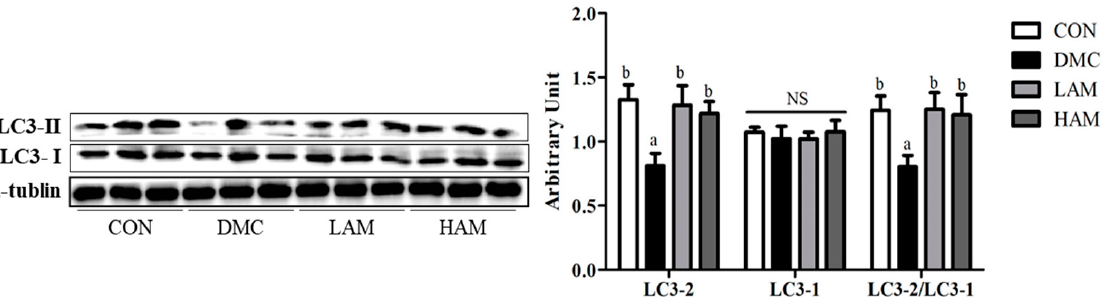
Figure 9. Effect of AME on autophagy in T2DM mice All values are reported as mean and SEM. Values with the different superscript letter were significantly different ( p < 0.05; ANOVA with post-hoc Duncan’s multiple range test). n = 6 mice in each group CON, normal control group (negative control); DMC, type 2 diabetic control group (positive control); LAM, diabetic group supplemented with low dosage (50 mg/kg BW) of AME; HAM, diabetic group supplemented with high dosage (100 mg/kg BW) of AME.